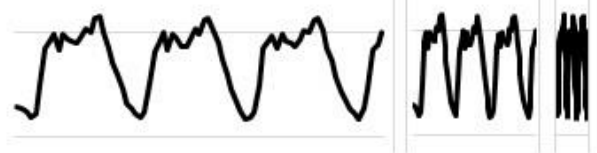
Sources: Reference [76] and IRENA [3]. Table 8. Monthly average electricity demand in MW—calculated by EnergyPLAN for RE2040. Figure 6. The effect of the zoom out of time scale in Figures 5 and 7. Figure 6. The effect of the zoom out of time scale in Figures 5 and 7. Figure 6. The effect of the zoom out of time scale in Figures 5 and 7.